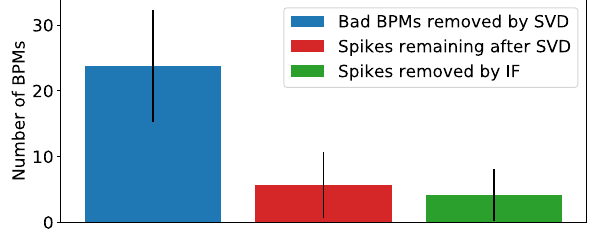
FIG. 4. Summary on cleaning results based on the number of outliers (spikes) per plane per beam appearing in computed β beating and phase advance averaged over ten measurements listed in Table II.